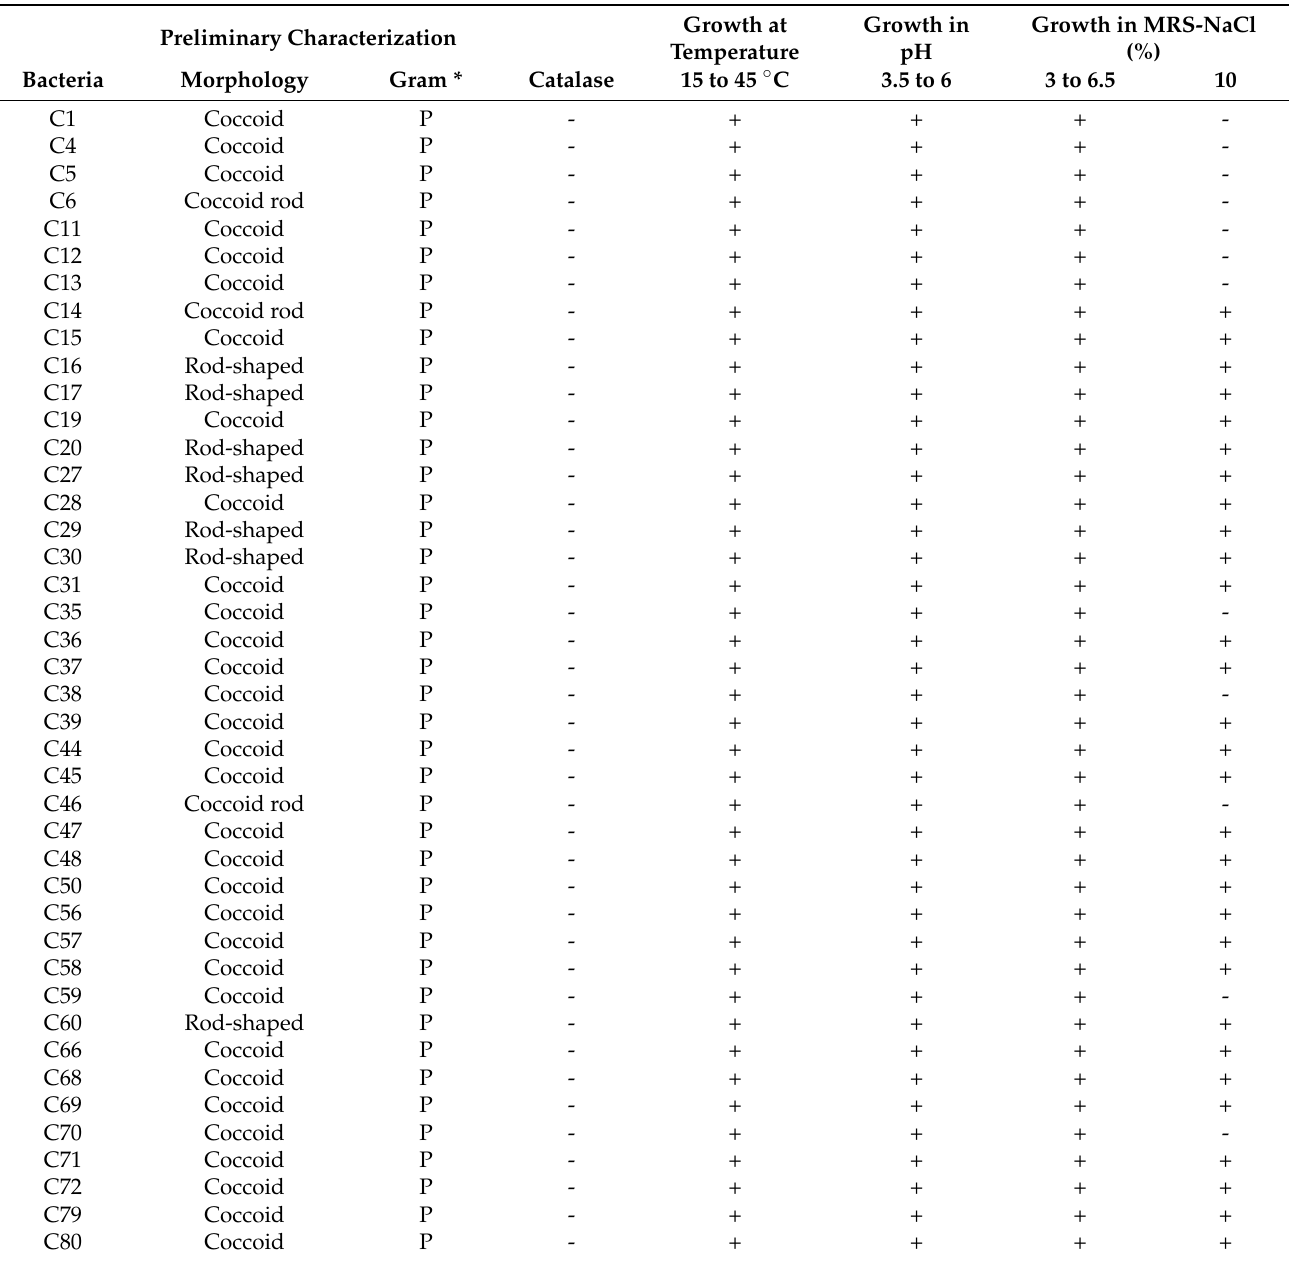
Table 1. Characterization of LAB isolated from dry-cured